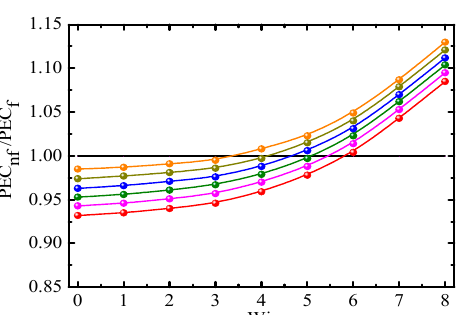
Figure 14. PEC nf /PEC f vs. Weissenberg number for different Reynolds numbers ( β 0 = 0.2, Φ = 1.0%, α = 0.2). ⸺ ● ⸺ : Re = 0.5; ⸺ ● ⸺ : Re = 1; ⸺ ● ⸺ : Re = 2.5; ⸺ ● ⸺ : Re = 10; ⸺ ● ⸺ : Re = 100; and ⸺ ● ⸺ : Re = 500.